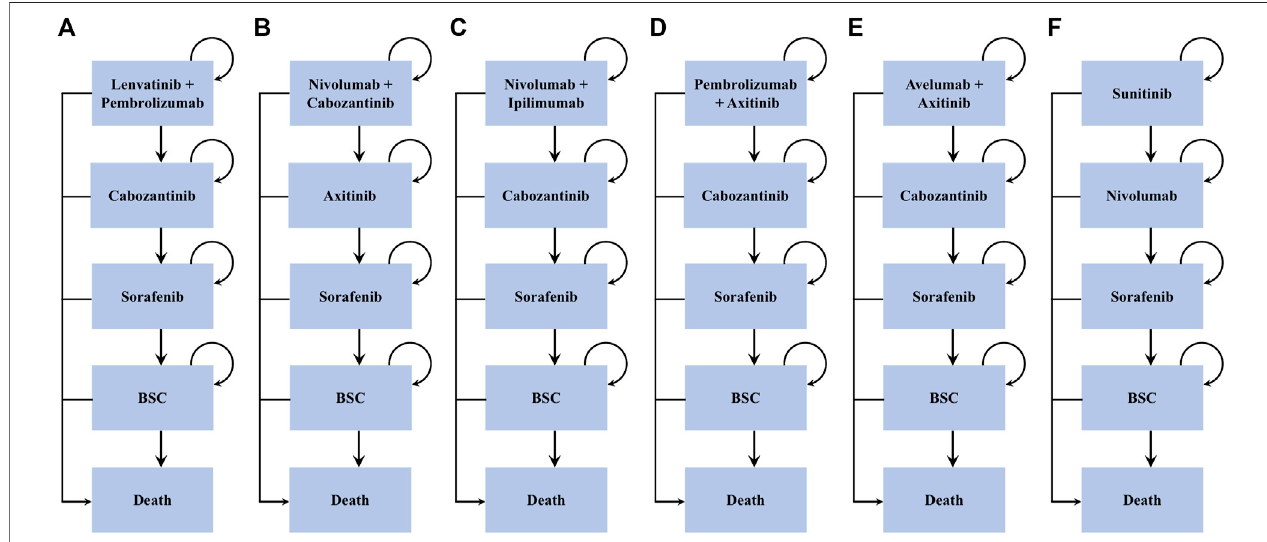
FIGURE 1 | Treatment sequences. *BSC (cid:1) best support care. Arrows represent patients staying on current treatment or moving to the next line of treatment.